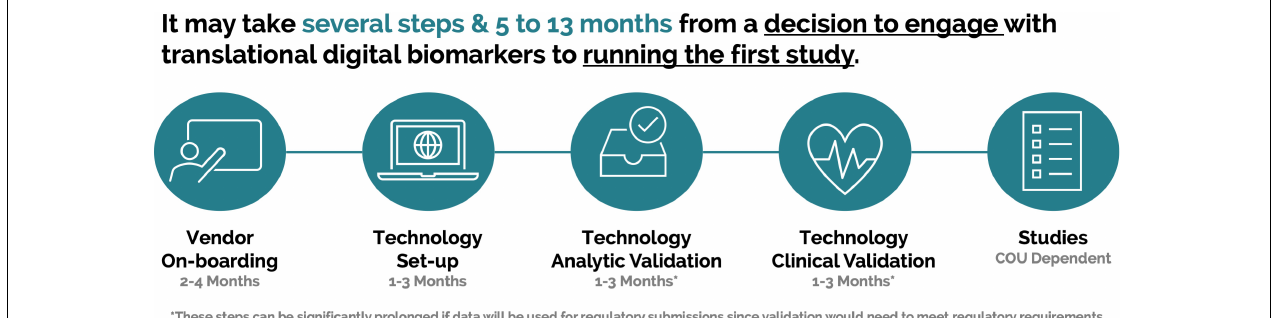
FIGURE 3 | Example timeline for a pharmaceutical company from decision to engage with a scalable digital biomarker technology to running a first study. TABLE 2 | Barriers and solutions to implementation of scalable digital biomarker technologies that end users can